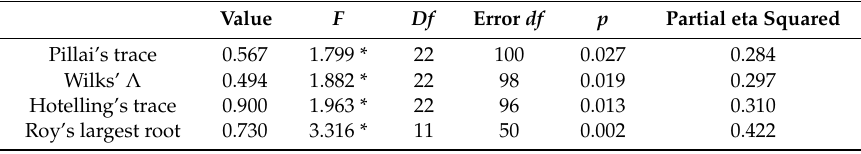
Table 4. Textual organizational measures multivariate test. Table 5. Textual organizational measures tests of between-subjects e ff